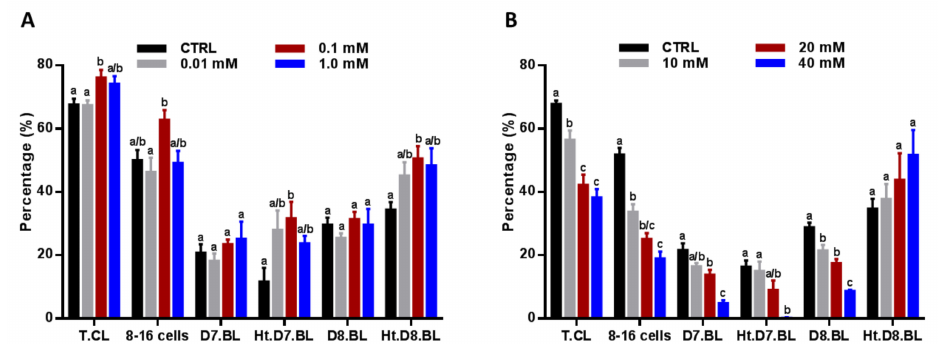
Figure 3. E ff ect of NAM administration during in vitro maturation (IVM) on the developmental competence of embryos. Day-4 total cleavage and 8–16 cell-stage embryos, and day-7 and day-8 blastocyst development and hatching rates were recorded in embryos derived from oocytes treated with low ( A ) and high ( B ) NAM concentrations. T.CL: day-4 total cleavage; D.7BL: day-7